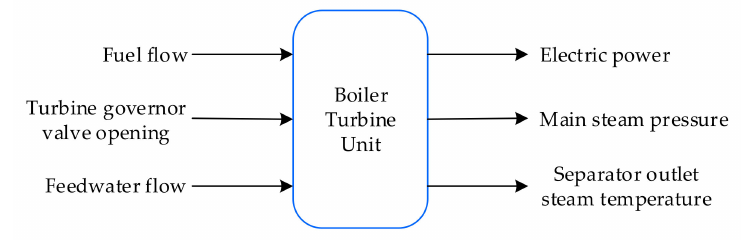
Figure 2. The three-input, three-output system of the USC